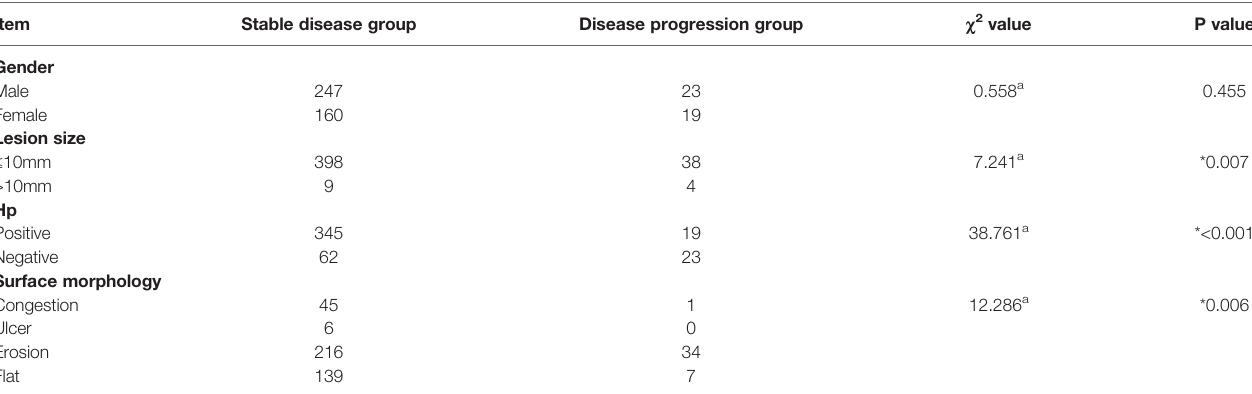
TABLE 3 | Outcome of low gastric intraepithelial neoplasia in stable and progression groups.